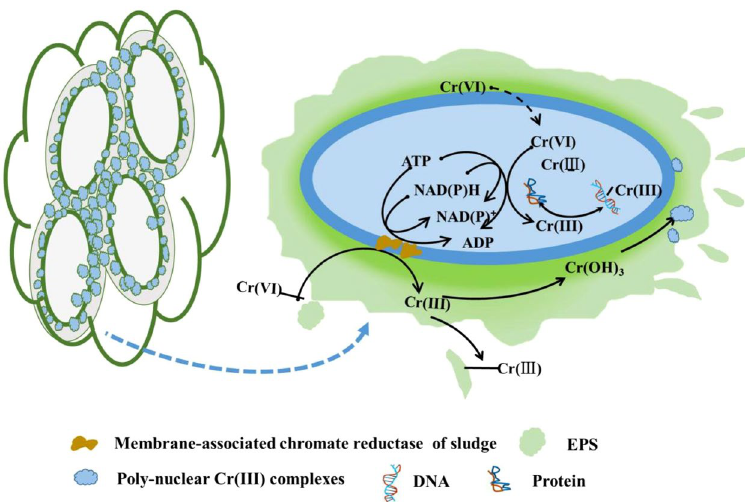
Figure 6. A schematic diagram of Cr(VI) reduction by anaerobic activated